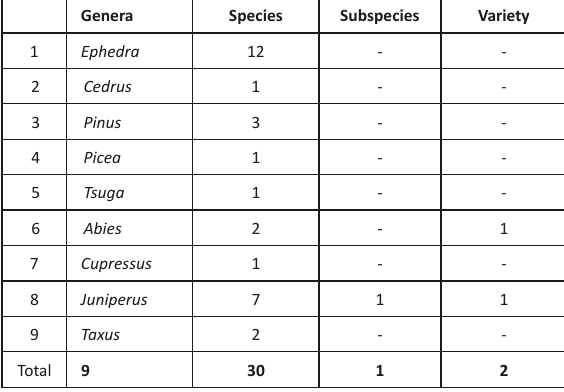
Table 2. Native gymnosperms of the Indian western